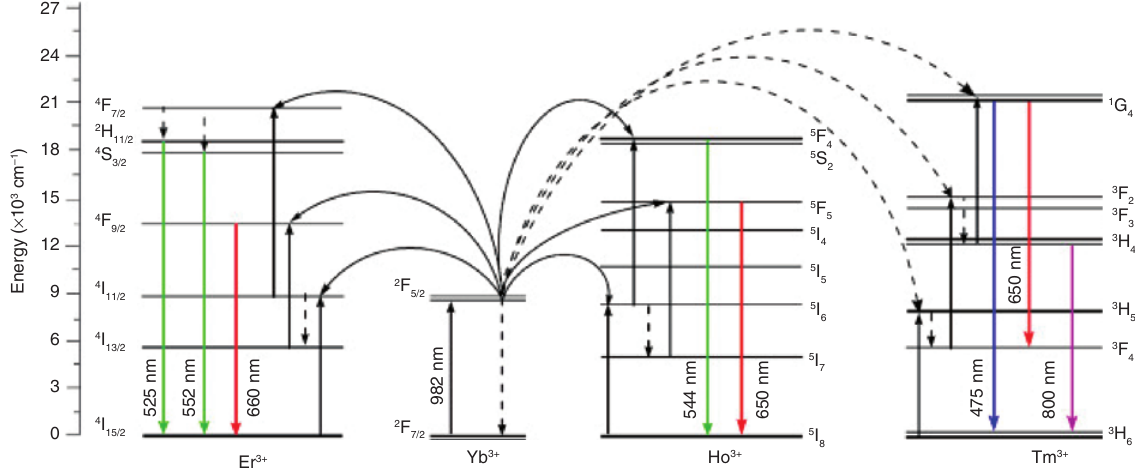
Figure 6: Energy diagrams of Yb 3 + , Er 3 + , Ho 3 + , and Tm 3 + and ETs involved in their UC luminescence. Taken from [217]. Reproduced with permission of Elsevier. Copyright © 2016.